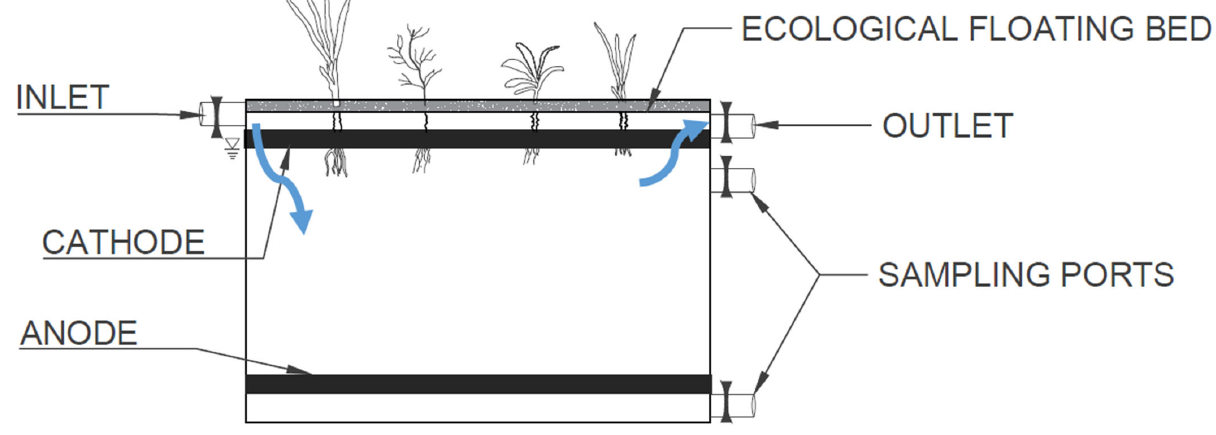
Figure 8. Representation of the floating bed ‐ MFC (EFB ‐ MFC) ( adapted from Yang et al., (2021) [78]).